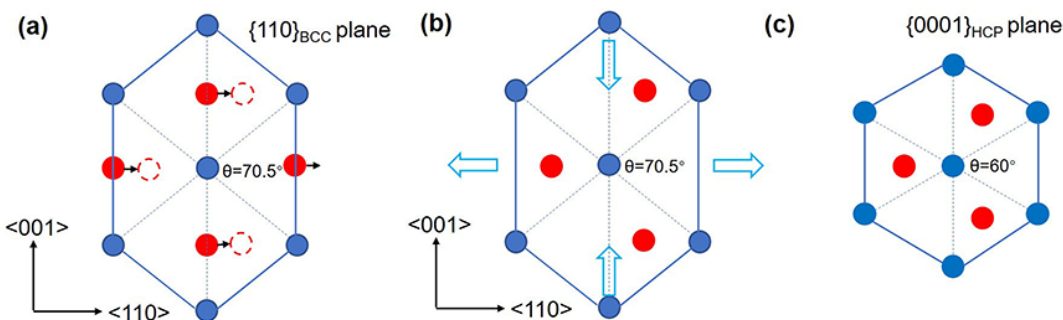
Figure 10. The schematic diagram of martensitic transformation mechanism from BCC to HCP